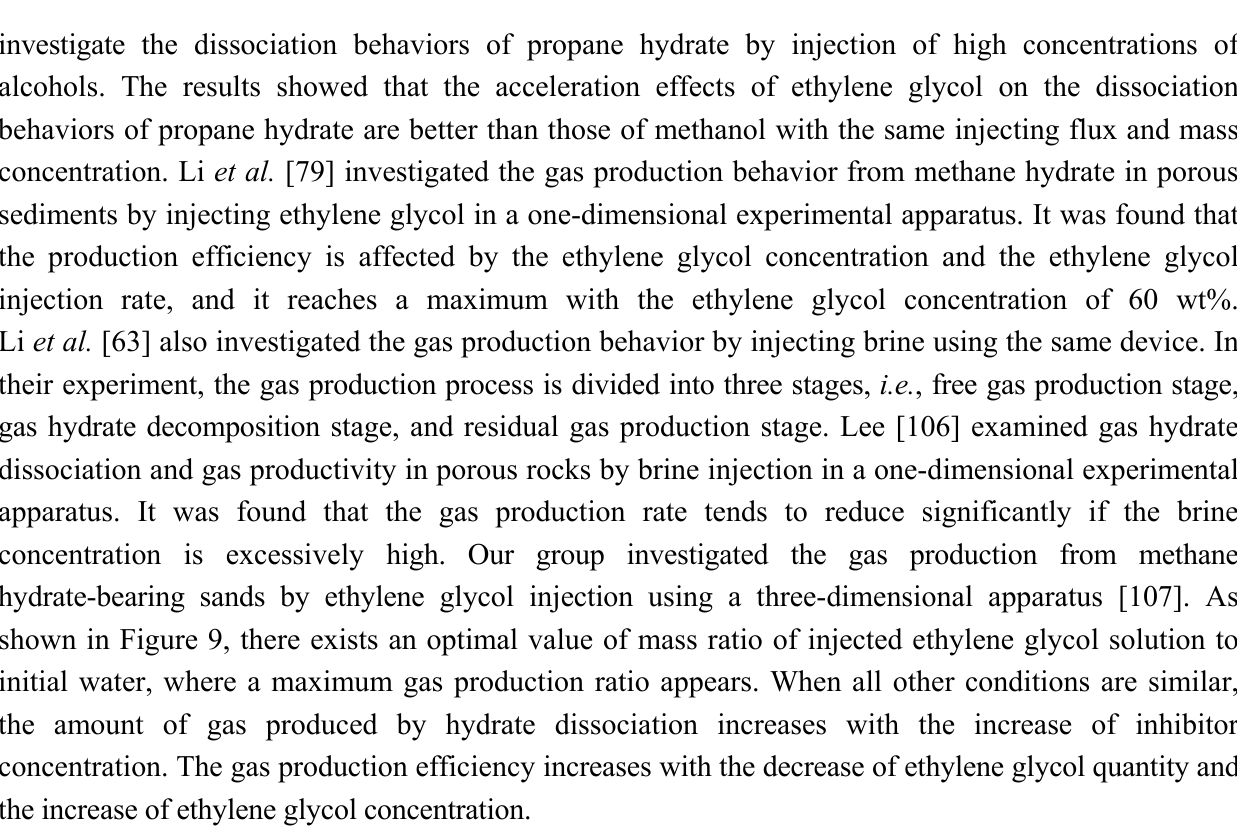
(the ratio of injected ethylene EG-w